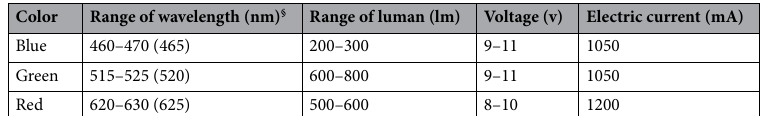
Table 1. Specification of high intensity light-emitting diodes (LED). § The wavelength in the parentheses is the highest peak wavelength of each